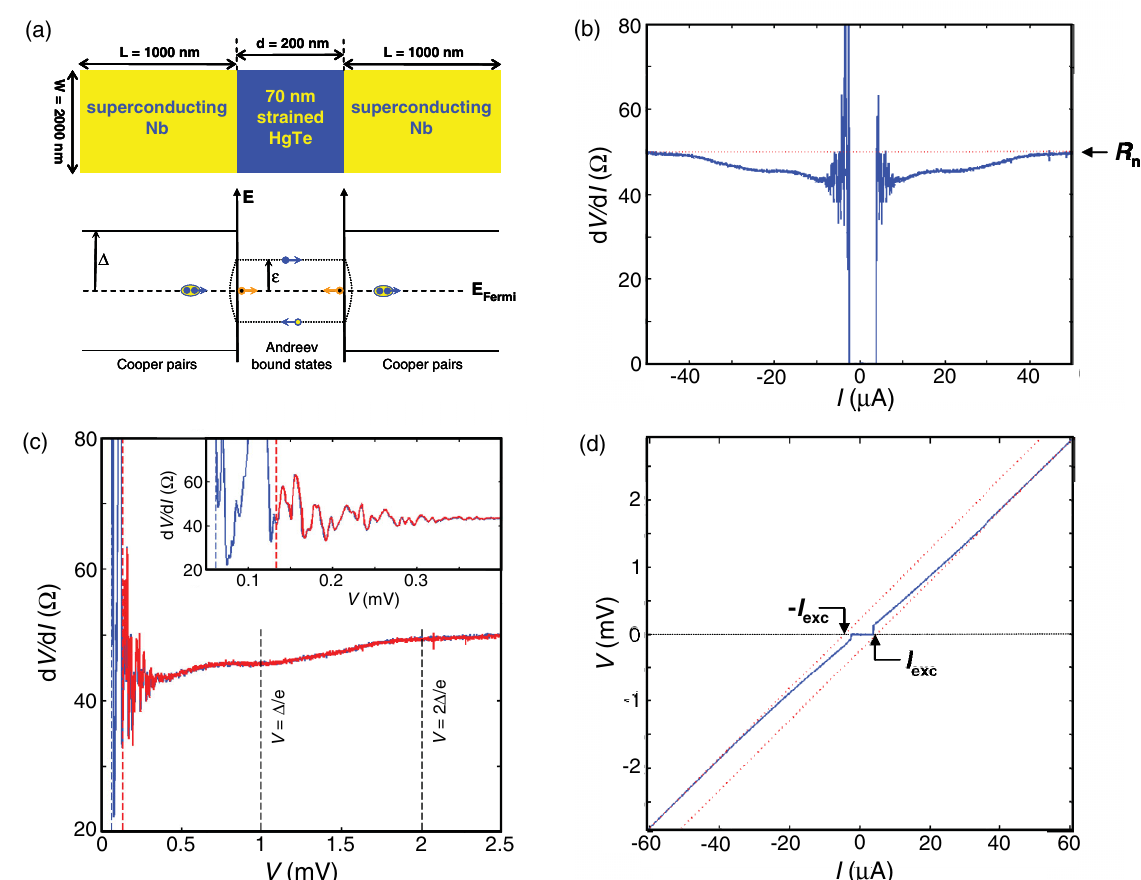
FIG. 2. (a) Geometric dimensions of the Josephson junction and the corresponding energy diagram showing Andreev modes at finite- energy ( " > 0 ) and zero-energy values ( " ¼ 0 ). The presence of zero-energy modes is predicted to give rise to a 4 (cid:1) -periodic supercurrent through the topological surface states [8]. However, normal scattering in the weak link can remove unprotected zero modes, leading to a 2 (cid:1) -periodic Josephson effect [9,17,35]. (b) Differential resistance versus current bias at T ¼ 25 mK (ascending bias sweep). In the high-current regime, the differential resistance converges to the value of the normal resistance R n (cid:2) 50 (cid:1) . When the current is decreased below a critical value, the differential resistance drops to zero, corresponding to a supercurrent regime. (c) Differential resistance plotted versus the voltage across the junction at T ¼ 25 mK . When V < 2(cid:2) = e , dV=dI decreases because of Andreev reflections. The feature at V (cid:2) (cid:2) = e can be attributed to multiple Andreev reflections. The inset shows reproducible, aperiodic fluctuations, which are related to the Josephson effect. The red (blue) curve is a bias sweep in the ascending (descending) direction. The red and blue dashed, vertical lines indicate the switching ( V s ) and retrapping voltages ( V r ), respectively. (d) Nonlinear I - V characteristic of the junction at T ¼ 25 mK (ascending bias sweep). The red dotted lines, with a slope corresponding to R n (cid:2) 50 (cid:1) , (cid:2) 4 : 5 (cid:3) A , which is directly related to Andreev reflections cross the V ¼ 0 axis at a finite current value. This is the excess current I exc in the junction